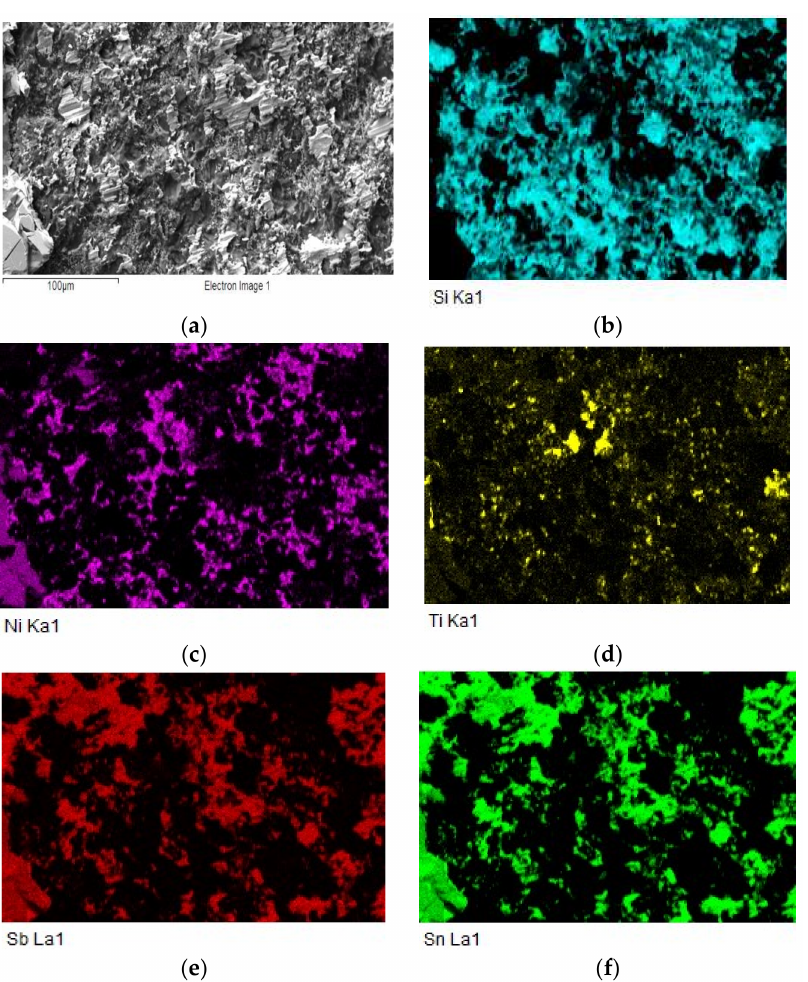
Figure 22. Fractured surface of soldered joint of SiC/Sn5Sb3Ti/Ni and the planar distribution of individual elements; ( a ) fracture morphology; ( b ) Si; ( c ) Ni; ( d ) Ti; ( e ) Sb; ( f ) Sn.